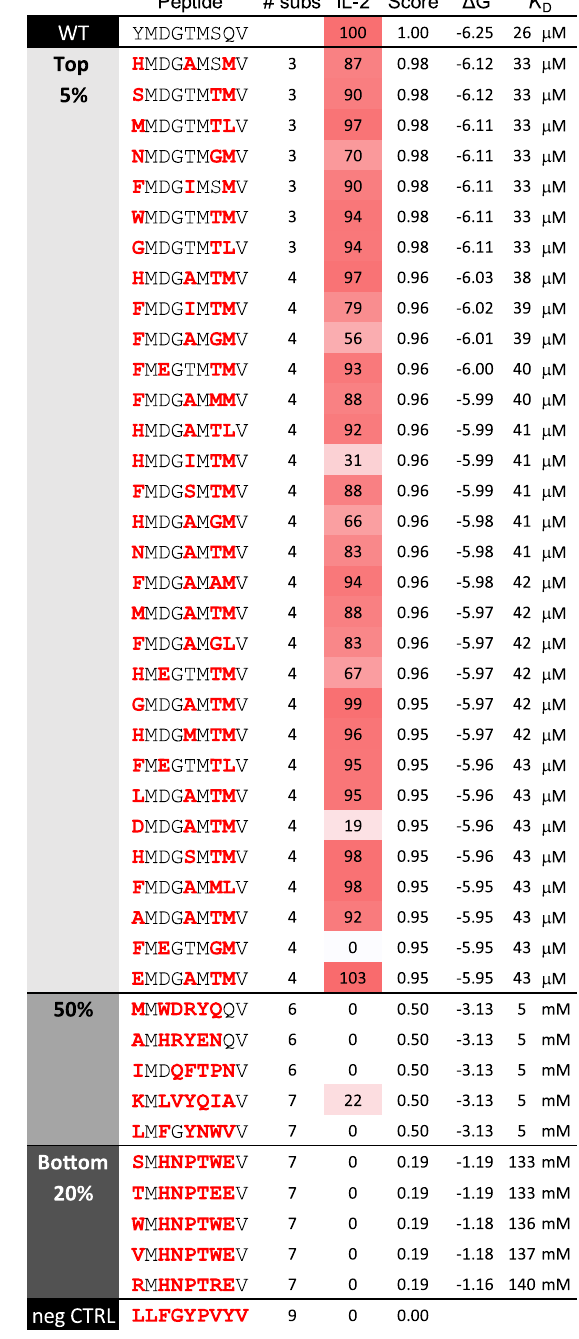
amino acid changes). The sequence of each peptide is listed. Amino acid changes relative to the Tyr 370D peptide are in bold red font. The number of amino acid substitutions is given in the “ # subs ” column. IL-2 produced normalized to the amount produced by the WT peptide is colored red (maximum) to white (zero), along with the percent. The score from the fi ngerprint analysis is indicated by the “ score ” column.Theestimated Δ G°(inkcal/mol)and K D forTCRbinding,computed from the score as described in the Methods, are also indicated. “ neg CTRL ” indi- cates a negative control peptide unrelated to Tyr 370D